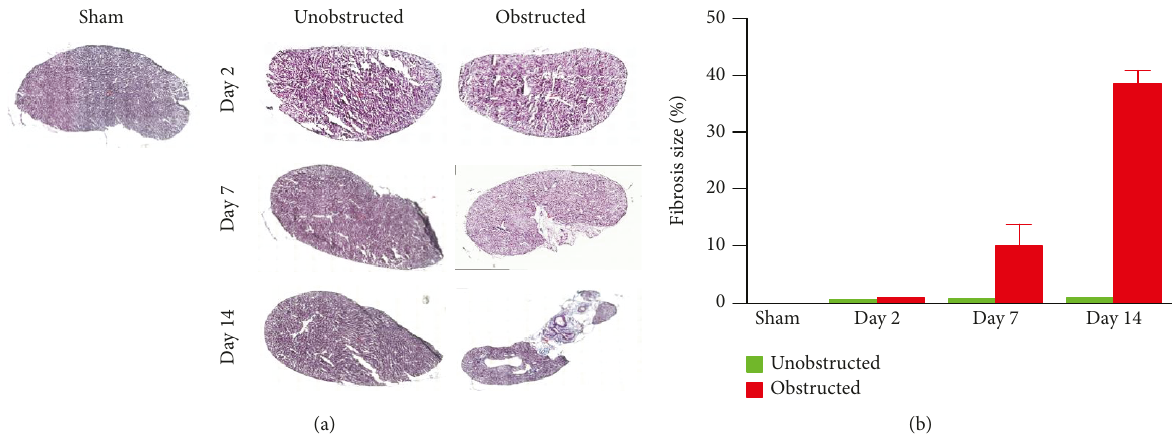
Figure 1: Masson ’ s staining for renal fi brosis. (a) Representative images of renal tissues. (b) Quantitative data on the fi brotic area in each group.